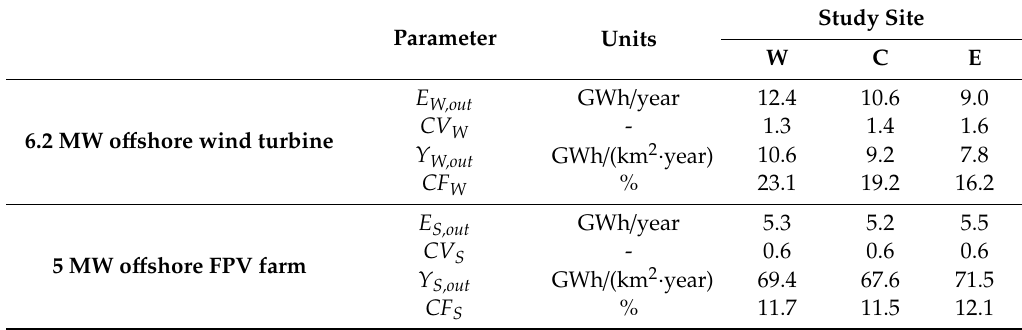
Table 4. Energy production ( E ), coefficient of variation ( CV ), specific yield ( Y ) and capacity factor ( CF ) for the offshore wind turbine and the offshore FPV farm.